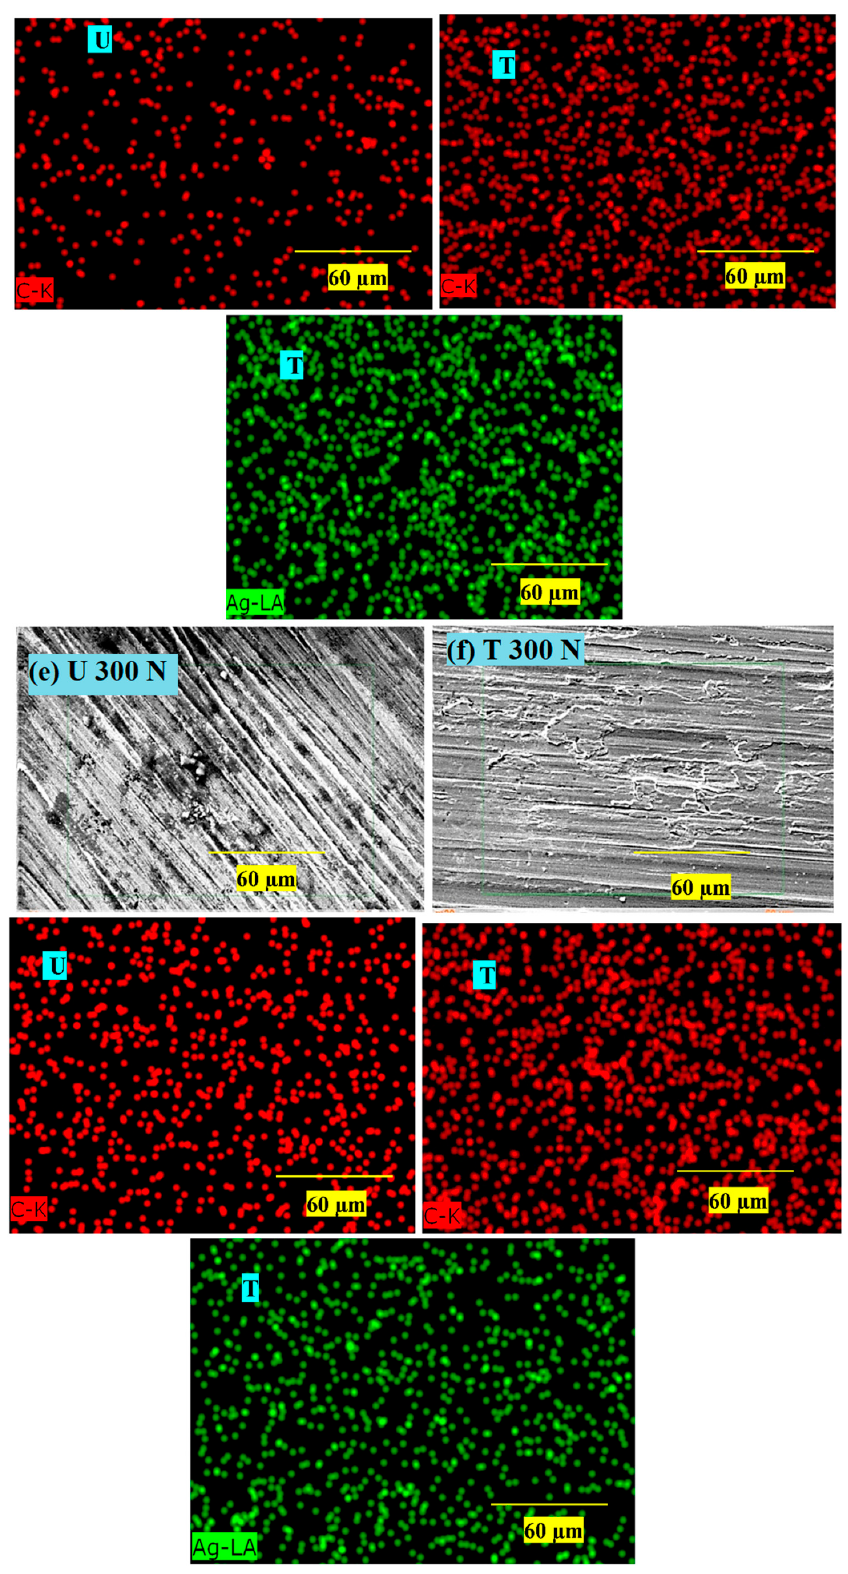
Figure 13. SEM-EDAX dot maps of the wear tracks on the discs worn at 100–300 N against composite U ( a , c , e ) and composite T ( b , d , f ). * yellow line indicates the scale and green square indicates the region of